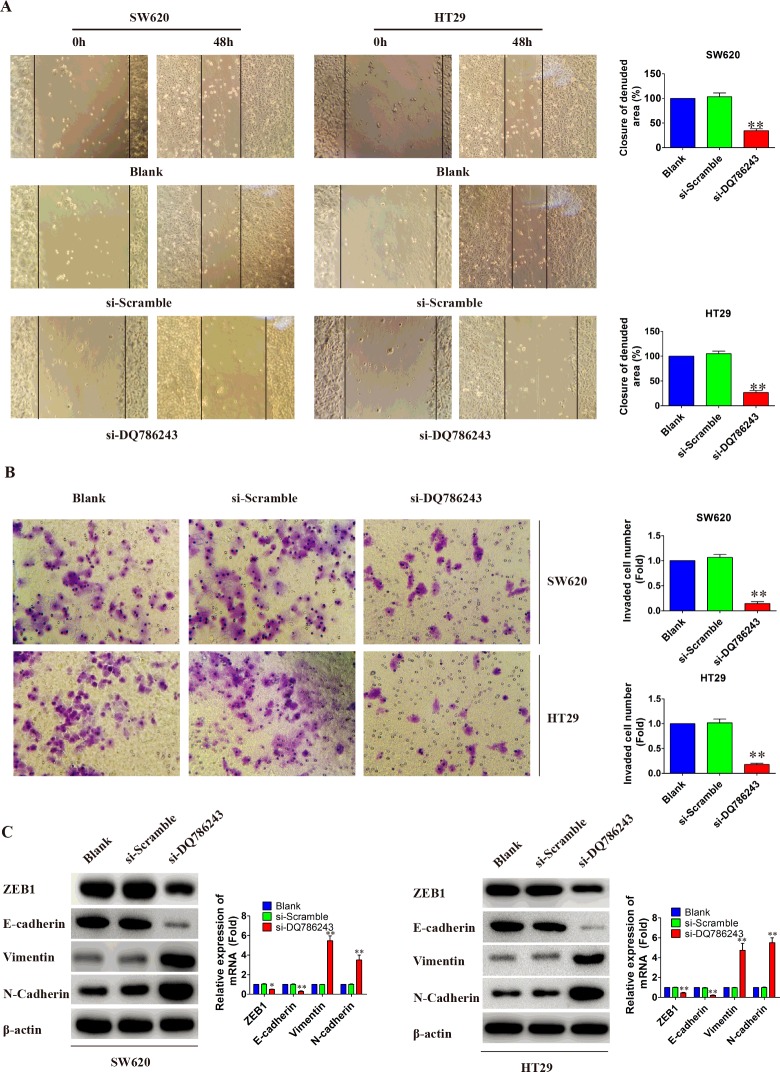
Knockdown LncRNA DQ786243 inhibited cell migration and invasion in vitro(A) Cell migratory abilities were measured by a wound healing assay. The wound areas were measured by ImageJ software. These data are shown as the mean±S.D. of three independent experiments. (B) Transwell invasion (crystal violet staining, original magnification ×200). SW620 and HT29 cells transfected with si-DQ786243 had a little cells migrated through the basement membrane, compared with si-Scramble and Blank groups (**P<0.01). No significant difference was observed between si-Scramble group and Blank group (P > 0.05). (C) The expression of EMT-related proteins in SW620 and HT29 cells by western blot. The levels of ZEB1 and E-cadherin were down-regulated in SW620 and HT29 cells transfected with si-DQ786243 (*P<0.05, **P < 0.01). But, the expression of Vimentin and N-cadherin were significantly increased in the both cells (**P<0.01).